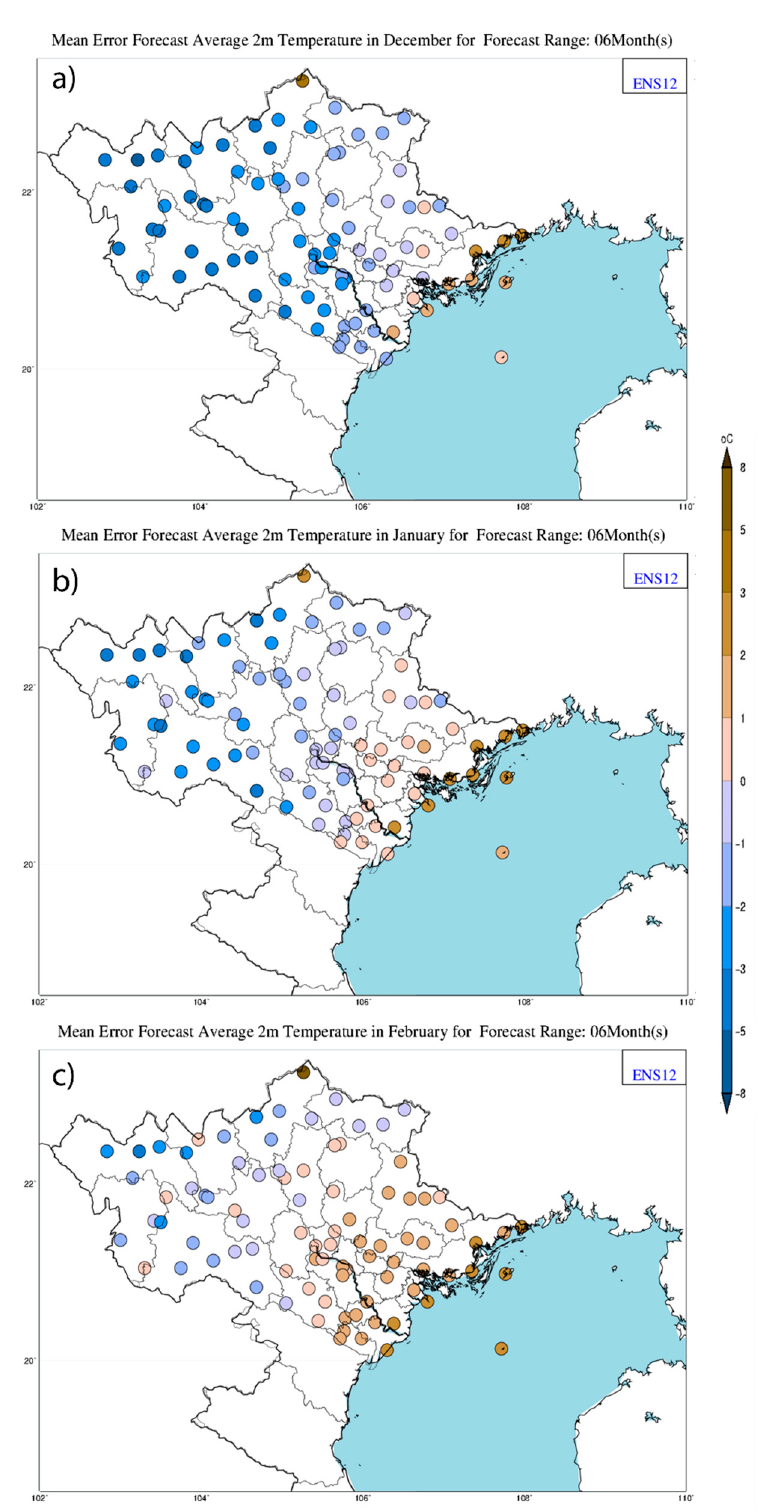
Figure 5. MEs in 1998–2018 of ENS12 at stations in northern Vietnam for monthly temperatures in ( a ) December, ( b ) January, and ( c ) February at the six-month forecast range. The unit is ◦ C.